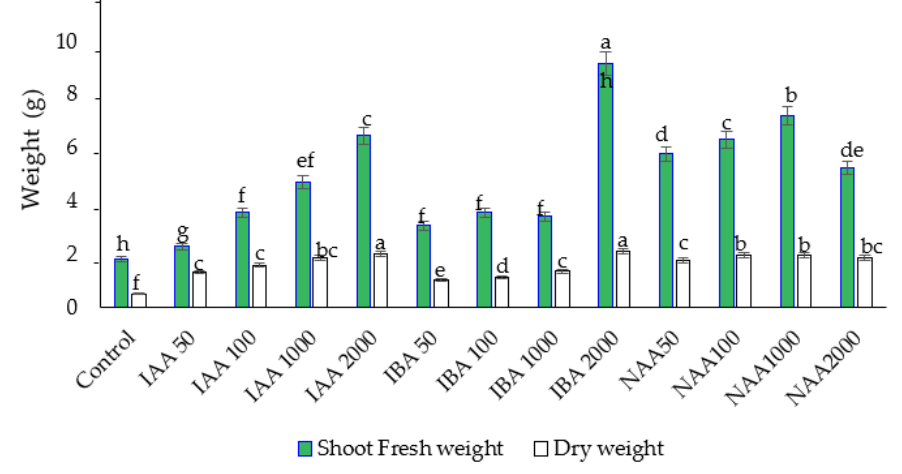
Figure 2. The effect of auxin concentration on shoot fresh and dry weight in C. indicum. Different letters indicate statistical differences as assessed by Duncan’s multiple comparison tests ( p < 0.05).